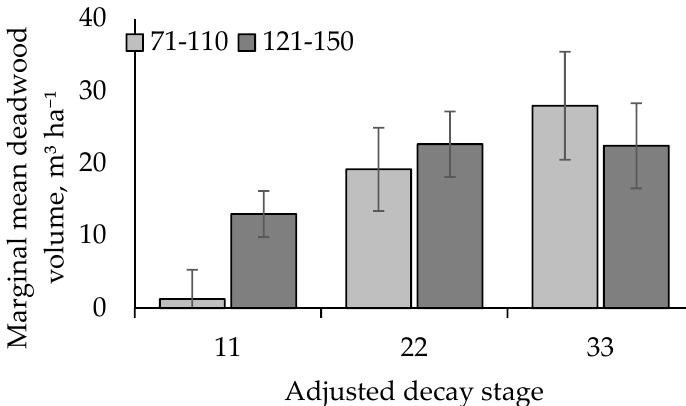
Figure 4. Volume of deadwood (± confidence interval) in recently unmanaged mature (71–110) and old-growth (121–150) stands by adjusted decay stages: (11) recently dead, (22) weakly decayed, and (33) moderately to almost completely decomposed.